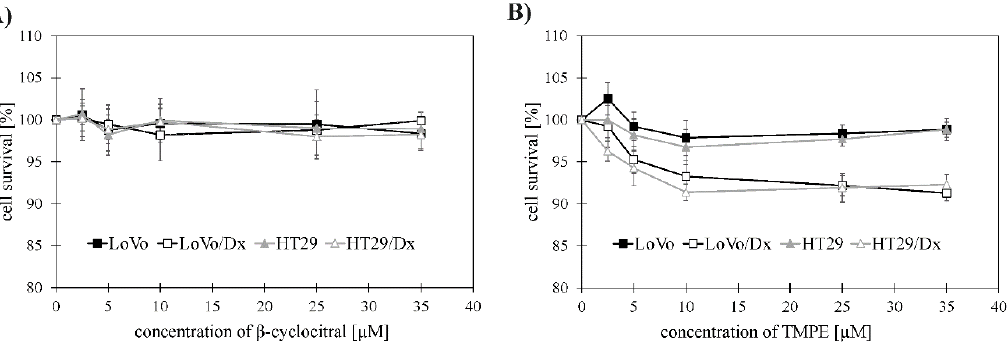
Figure 2. Cytotoxic activity of β-cyclocitral ( A ) and TMPE ( B ) against LoVo, LoVo/Dx, HT29, and HT29/Dx cells. The results were shown as mean + S.D. from three independent experiments. Cell survival at the concentrations of 2.5, 5, 10, 25, and 35 µM of the studied compounds were compared to the results obtained for the control (without the compound). The statistical significance was determined using Student’s t -test ( p < 0.05). Statistical significance was found only for TMPE in HT29/Dx cells (for all concentrations tested) and in LoVo/Dx cells (for concentrations equal or greater than 5 µM). Doubling times were: 36.44 ± 5.18 h for LoVo, 27.07 ± 4.53 h for LoVo/Dx, 30.02 ± 5.89 h for HT29, and 21.51 ± 3.27 h for HT29/Dx cell line.